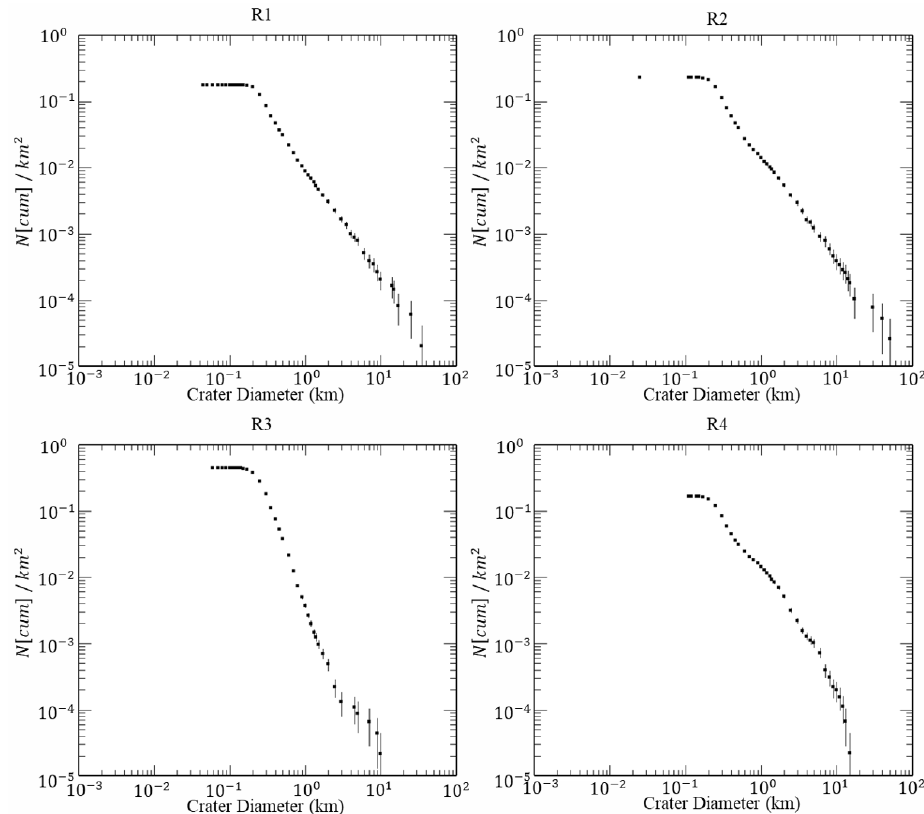
Figure 3. Labeled craters size-frequency distributions represented as CSFD plots, for our training areas. 10 2 Then, the labeled data were used to generate training and validation images. First, considering that the data should cover all kinds of craters, we sub-sampled the data of the four areas ten times and obtained eight images in total. Secondly, each image of the area was divided into a number of 512 pixel × 512 pixel image blocks, in order to speed up the model training and detection. Finally, pseudo-color images were constructed, in order to obtain the number of craters per image and to distinguish overlapping craters. In Figure 4, each crater contributes to an index value, such that the maximum value of the index is the number of craters in the image block.